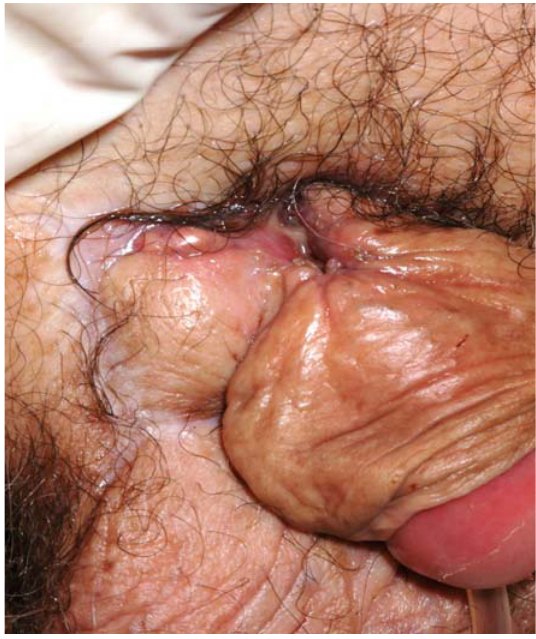
FIGURE 4. Healing SGPG of penis, 2 months after treatment with topical steroids and